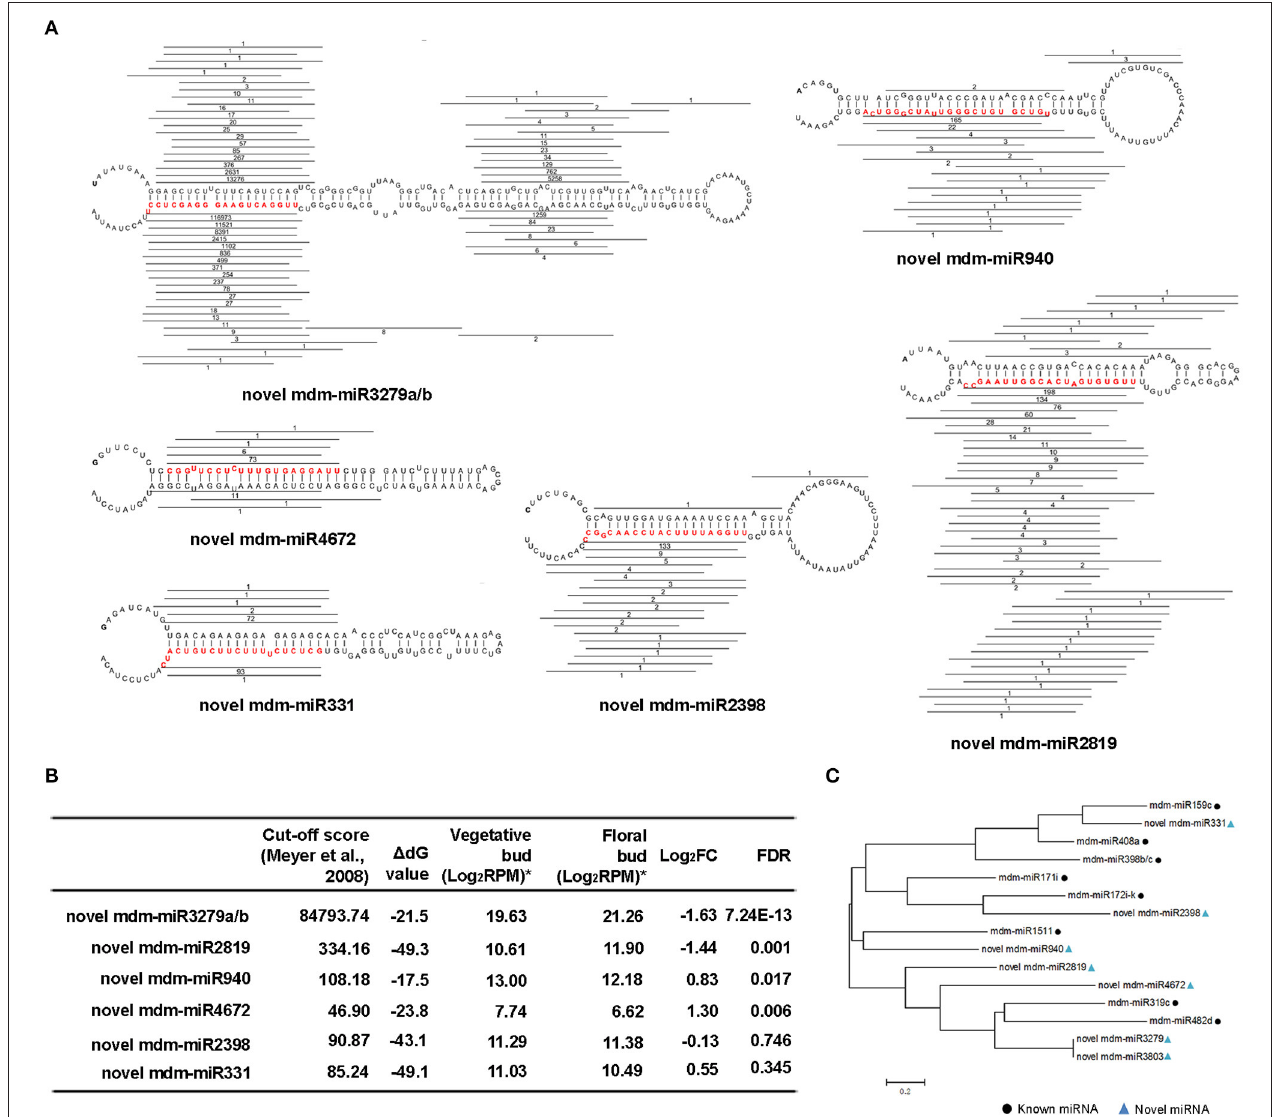
FIGURE 3 | Novel miRNAs that are correlated with floral transition from Malus domestica. (A) Novel miRNAs and their secondary structures of pri-miRNAs. The sequence of miRNA was labeled in red. All sRNAs were matched onto pri-miRNAs and their read numbers were shown for each unique read. (B) Expression pattern of novel miRNAs. * All the values were given as Log 2 CPM (Counts per million). (C) Phylogenic tree of novel miRNAs and some known miRNAs. The phylogenetic tree was constructed using the Neighbor Joining Method with the Mega 7.0 software. Black square indicated known miRNA and blue triangle indicated novel